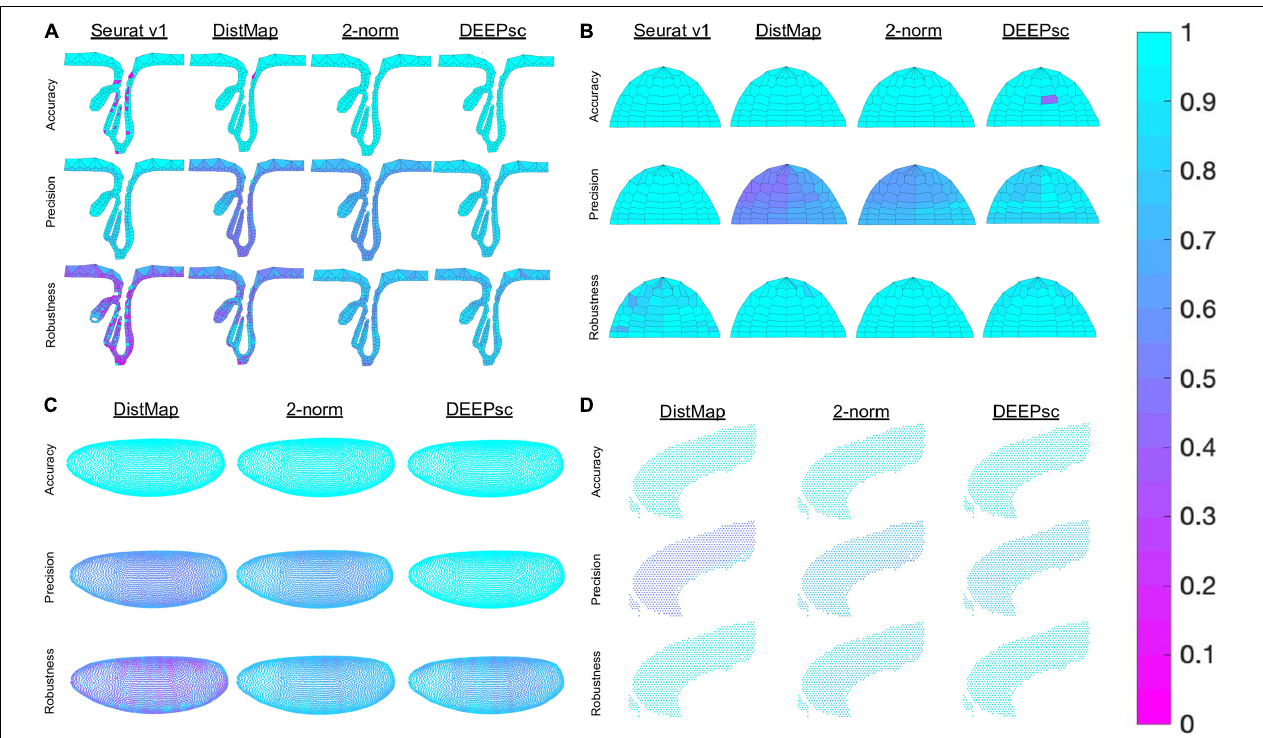
FIGURE 5 | Heatmap representation of the various components of the performance score on a per position basis in (A) the follicle system, (B) the Zebrafish, (C) the Drosophila embryo, and (D) the murine frontal cortex. We were unable to run Seurat v1 on the Drosophila embryo and cortex data due to memory constraint. The penalty terms for each simulated cell, including robustness, were computed individually and plotted as a